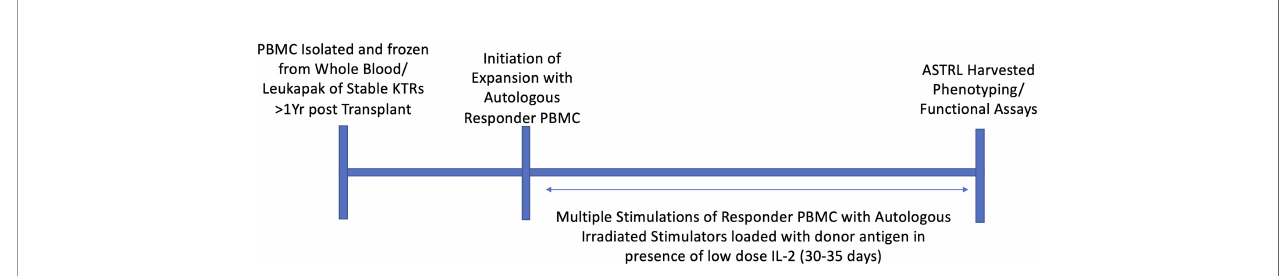
FIGURE 1 | Graphical representation of ex vivo expansion of ASTRL. ASTRLs were expanded from autologous PBMC of stable kidney transplant patients through multiple stimulations in presence of donor antigen and low dose IL-2 using the indirect pathway of allorecognition. A typical expansion process takes about 30 to 35 days. At the end of the expansion cells were harvested and phenotypic and functional characterization of the ASTRLs are